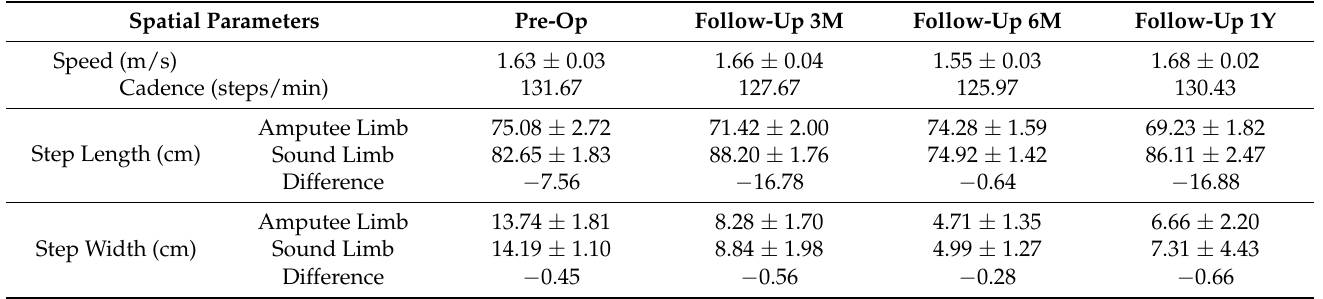
Table 2. Spatial gait parameters for the pre-operative gait analysis (socket-type prosthesis, ST) and for the follow-up gait analyses (osseointegrated prosthesis, OI). Data are presented for the fast gait as mean ± standard deviation. Note: “Difference” refers to a Sound limb—Amputee limb